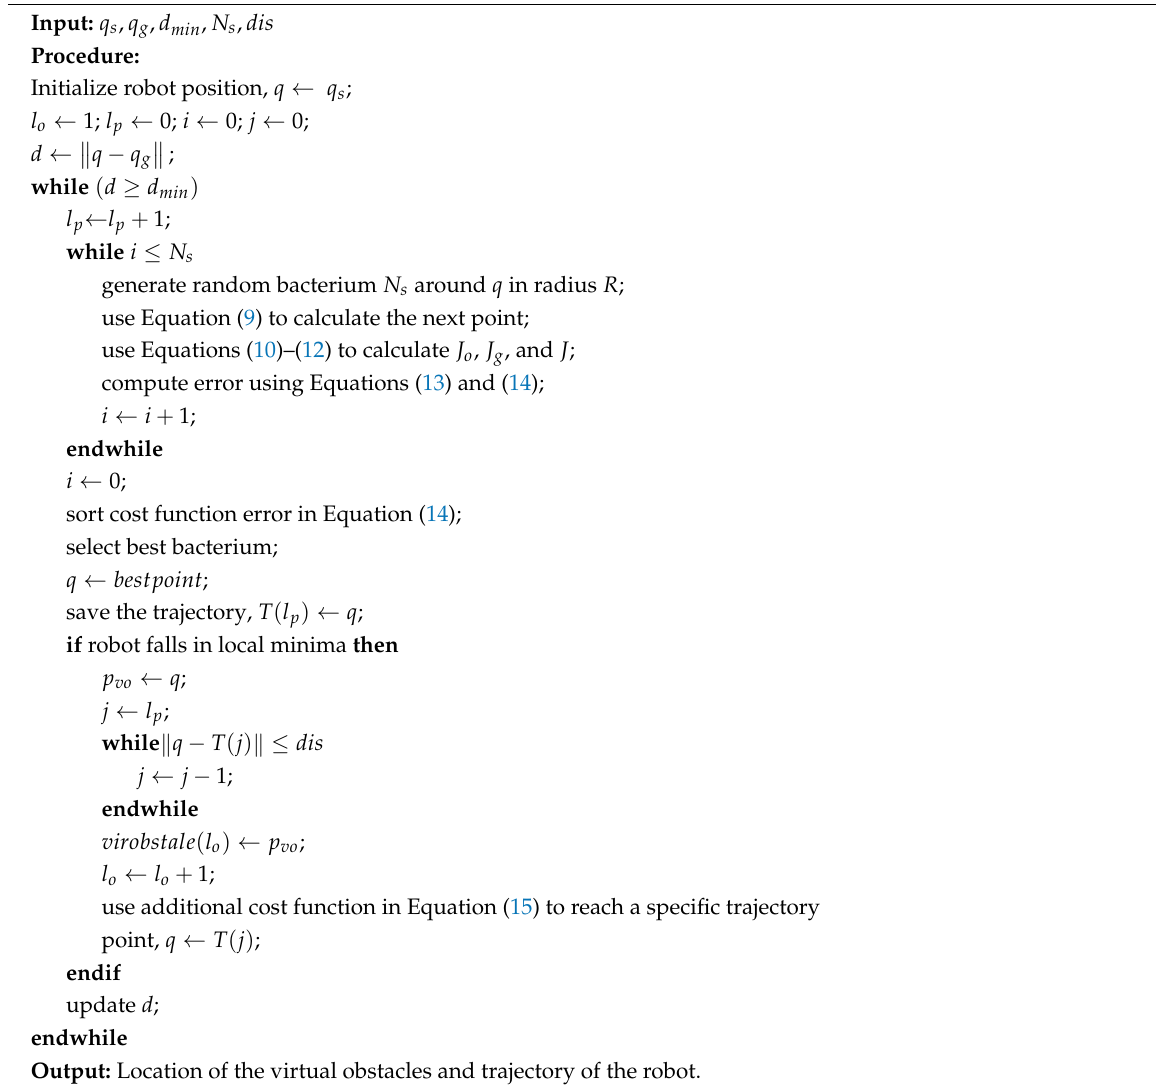
Algorithm 1 Pseudocode of the robust bacterial foraging (RBF)